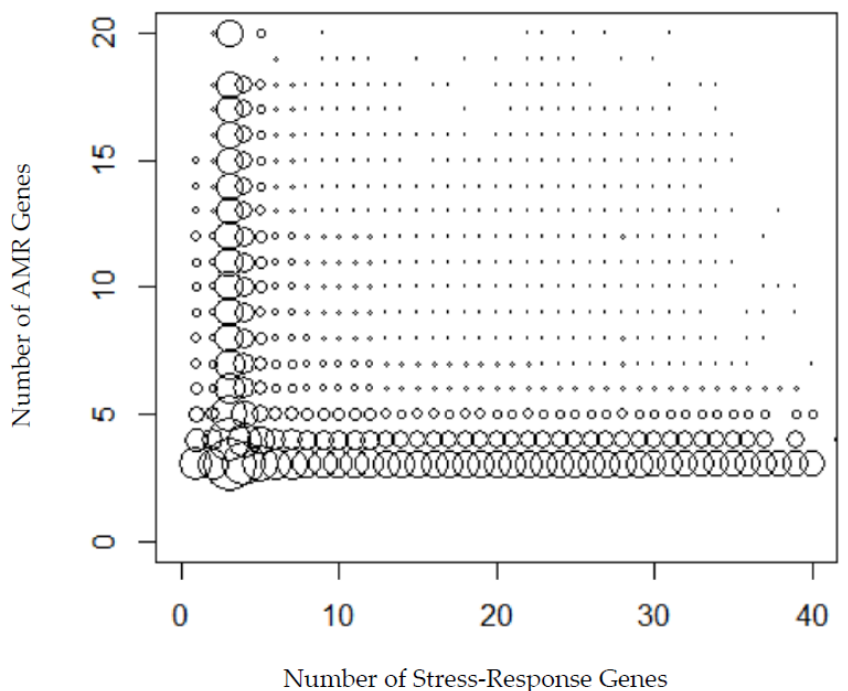
Figure 6. The number of samples (i.e., frequency) containing the number of stress response genes shown in the x -axis and the number of AMR genes shown in the y -axis. The size of the circle is proportional to the number of samples in the US data (a larger circle meaning a larger number of samples containing that many stress response and AMR genes).